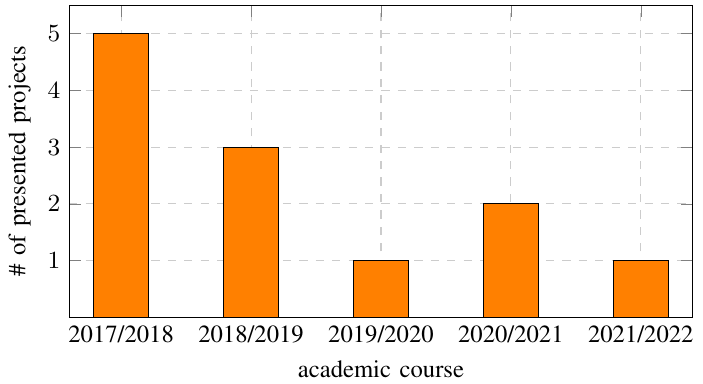
Figure 7. Number of projects presented in each academic course.